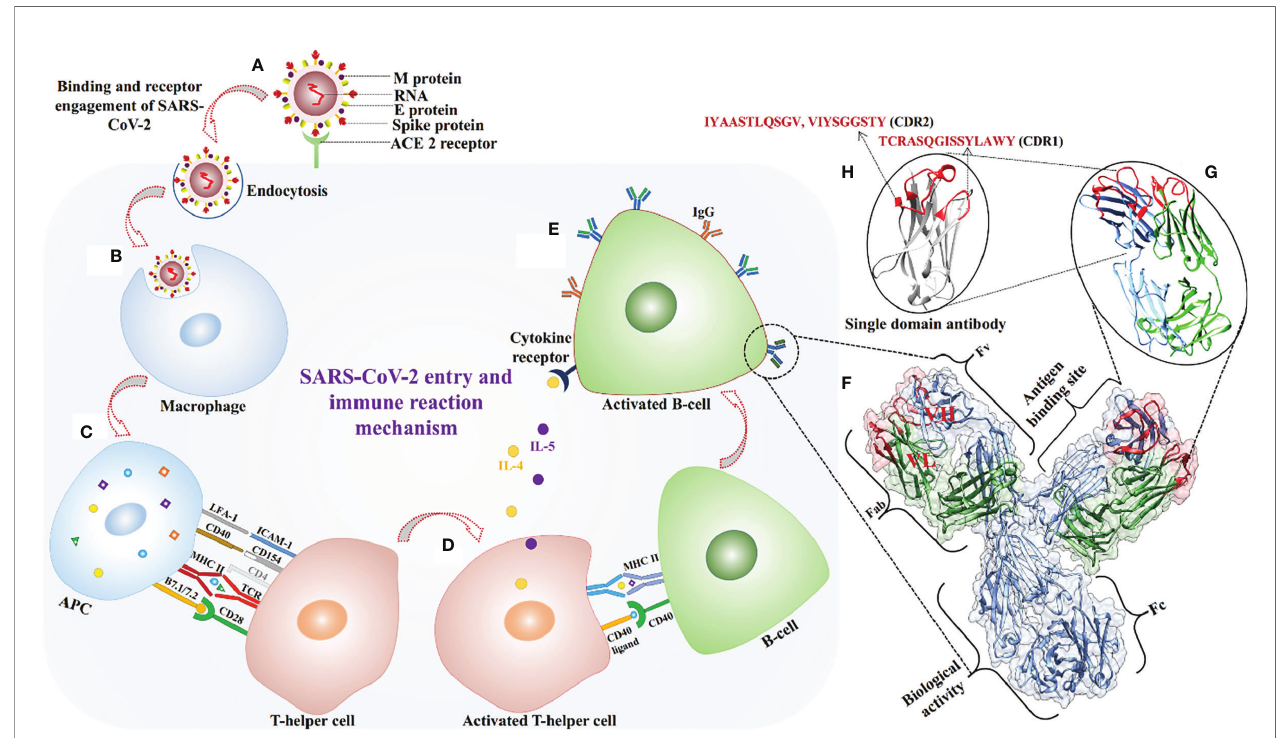
FIGURE 5 | SARS-CoV-2 virus entry in the host cell and antigen-paratopes interaction. (A) Recognition of ACE-2 receptor and virus fusion. (B) Virus engulfment by a macrophage. (C) Antigens from digested SARS-CoV-2 proteins are presented with MHC-II on the cell surface and engagement of helper T-cell for its activation. (D, E) Activated helper T-cell interacted with B-cell via CD40 ligand and released cytokines for activation of B-cell for secretion of antibodies. (F) Enlarge view of antibody structure on the right side, heavy (H) and light (L) chains are shown in blue, and green respectively, CDRs are colored in red and light variable domains (V H and V L ) are labelled in red. (G, H) The identi fi ed paratopes of light (IYAASTLQSGV, TCRASQGISSYLAWY) and heavy (VIYSGGSTY) chain sequences are shown in red